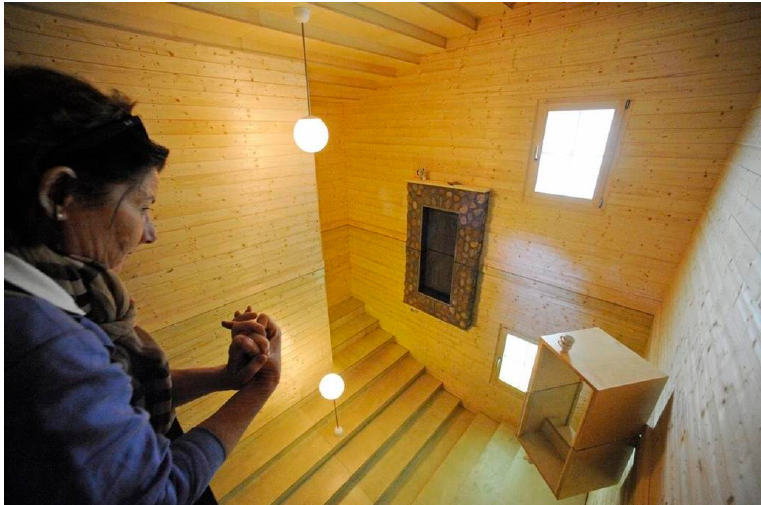
Figure 9. The Reflection Room, a cabin used for hypnosis sessions over 100 days at dOCUMENTA (13). Note that there is no physical mirror in the space.